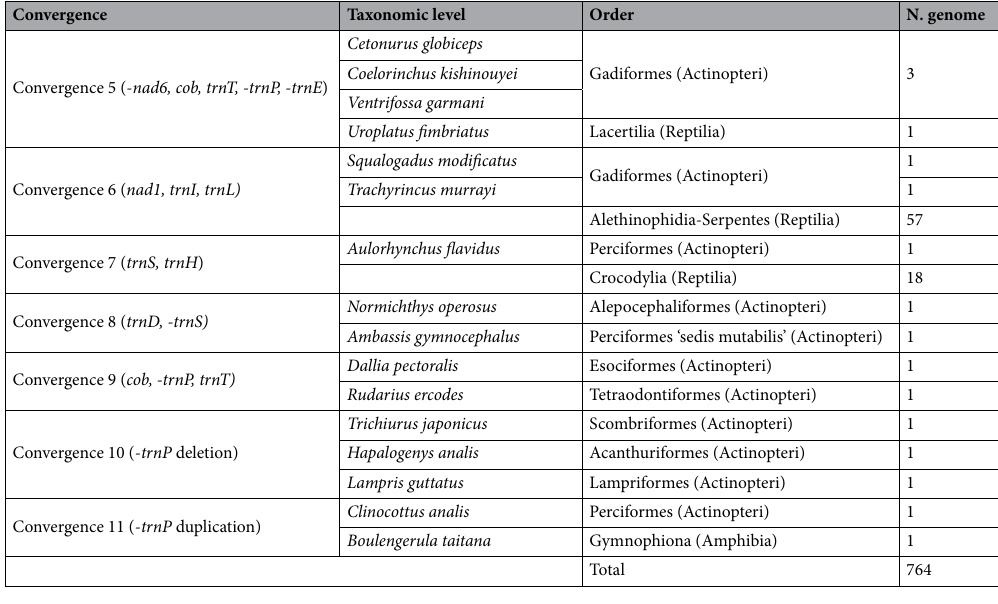
Table 2. Gene arrangement: convergence in the mitochondrial genome of